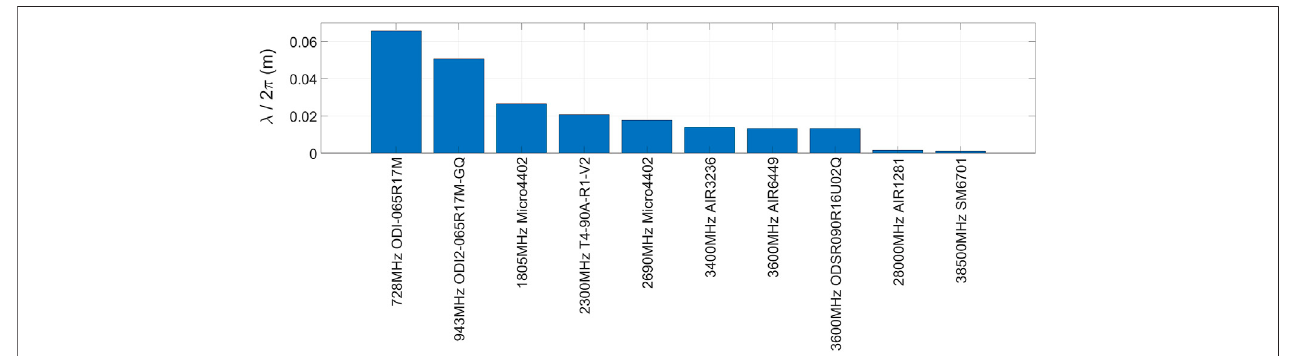
FIGURE 12 | Reactive near- fi eld boundaries for the BSs antennas selected in Section 4